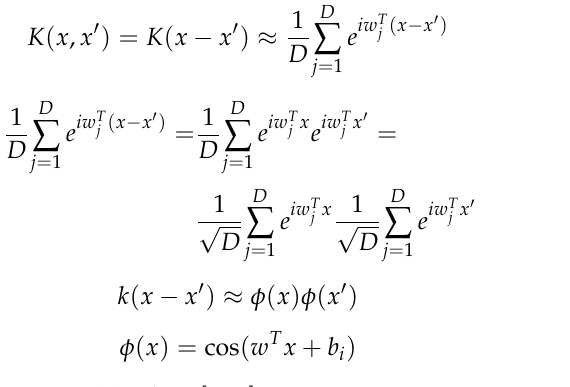
Figure 5. The plot on the left shows how we generate random direction, and the plot on the right shows how we project the data set into the new space using complex